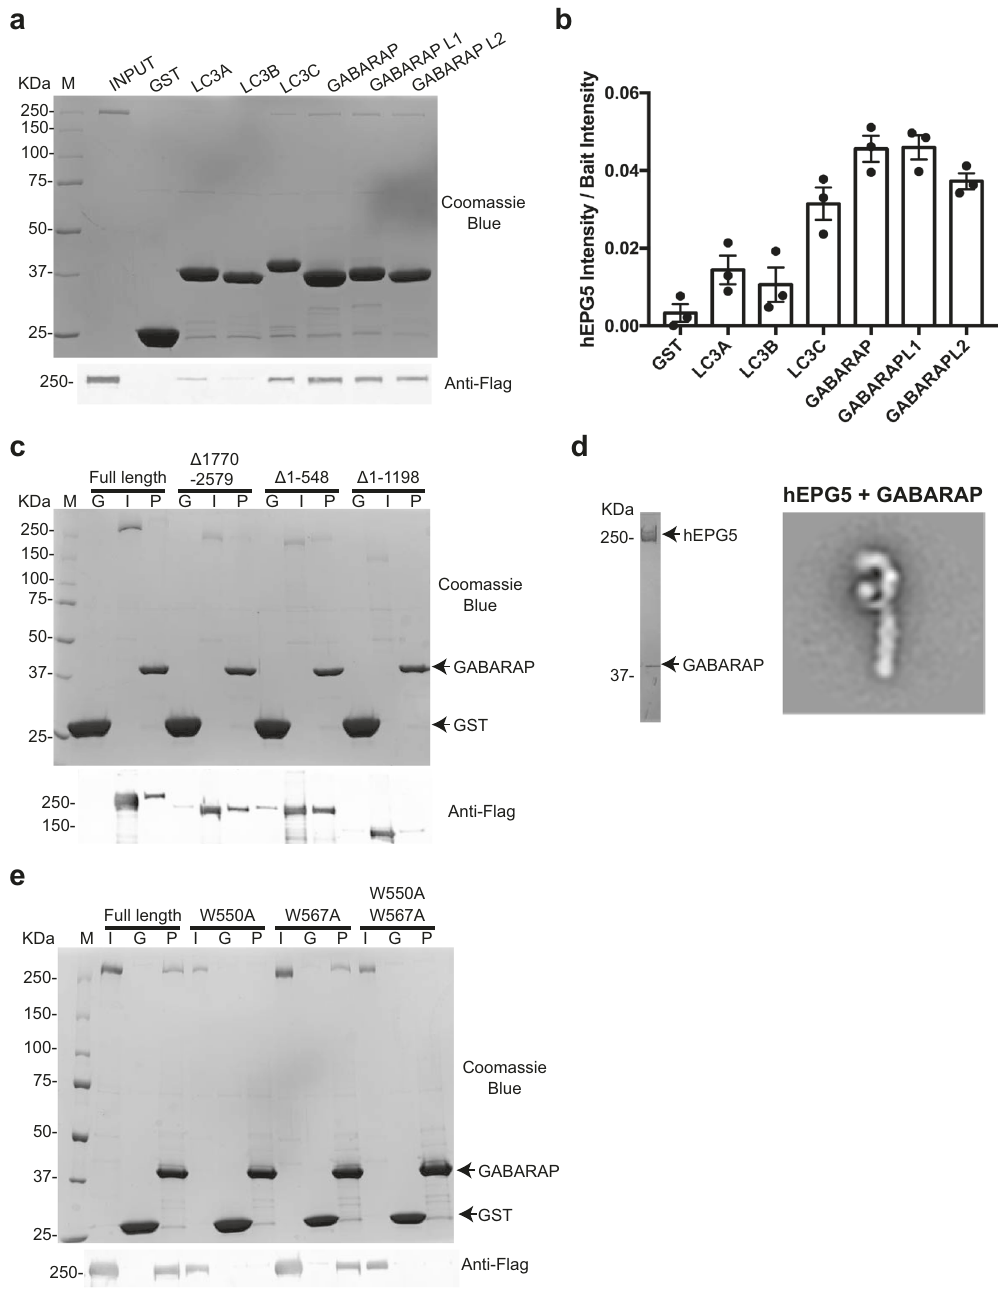
Fig. 2 In vitro pull-down assays of hEPG5 and the LC3/GABARAP subfamily. a , c , e Precipitation of FLAG-tagged wild-type and mutant hEPG5 using GST (control) and N-terminally GST-tagged LC3/GABARAP subfamily proteins as baits. Representative SDS – PAGE stained with Coomassie Blue (top panel) shows the input. Representative western blot (bottom panel) was probed by anti-FLAG antibodies. M, G, I, and P represent the protein marker, GST control, hEPG5 input, and pulldown, respectively. Experiments were performed in triplicates. a In vitro pull-down assays of hEPG5 with GST (control) and N- terminally GST-tagged LC3/GABARAP subfamily proteins used as baits. b Quanti fi cation of hEPG5 binding to GST (control) and GST-LC3/GABARAP subfamily proteins. Data are shown as mean ± SEM of three individual experiments. c Full-length and truncated hEPG5 (hEPG5 Δ 1770 – 2579 , hEPG5 Δ 1 – 548 , and hEPG5 Δ 1 – 1198 ) pull-down analysis using GST-GABARAP as bait. d (Left panel) SDS – PAGE of His-FLAG-hEPG5 in complex with GST-GABARAP isolated by nickel-immobilized metal af fi nity chromatography, stained with Coomassie Blue. (Right panel) Representative 2D class averages of hEPG5 in complex with GST-GABARAP. The additional GST-GABARAP density is denoted by the white arrow. e Wild-type and hEPG5 mutant (hEPG5 W550A , hEPG5 W567A , and hEPG5 W550A/W567A ) pull-down analysis using GST-GABARAP as W567 hEPG5 (Fig. 4c). On the other hand, side chains of the carbonyl oxygen and NH group of L570 hEPG5 forms hydrogen residues lining HP2 (Y49, V51, F60, L63, and I64) are engaged in bonds with the guanidinium group of R28 GABARAPL1 and car- bonyl oxygen of L50 GABARAPL1 at HP2 (Fig. 4c, f). The central hydrophobic contacts with L570 hEPG5 (Fig. 4f). In addition, W567 hEPG5 forms electrostatic interaction with the carboxyl residues of LIR2 also contributed to GABARAPL1 binding. group on E17 GABARAPL1 side chain at HP1, and the main chain I568 hEPG5 side chain forms hydrophobic interaction with the